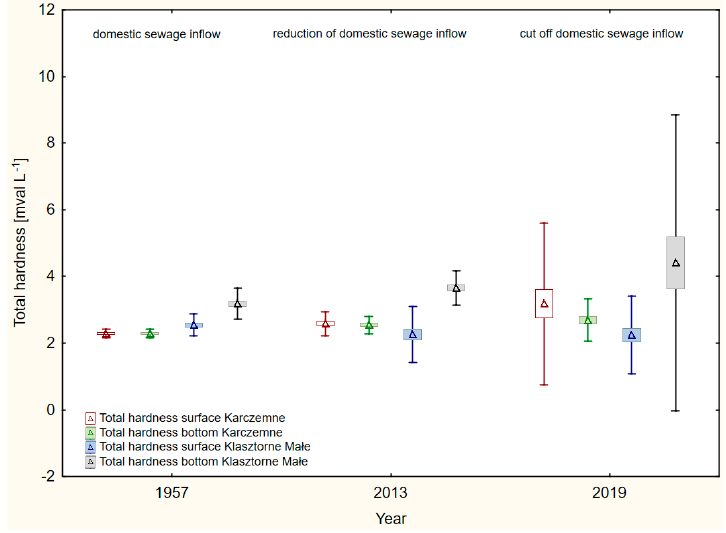
Figure 11. Mean annual values of total hardness (box ± SEM; whisker plots ± SD) in the water of Karczemne and Klasztorne Małe lakes.